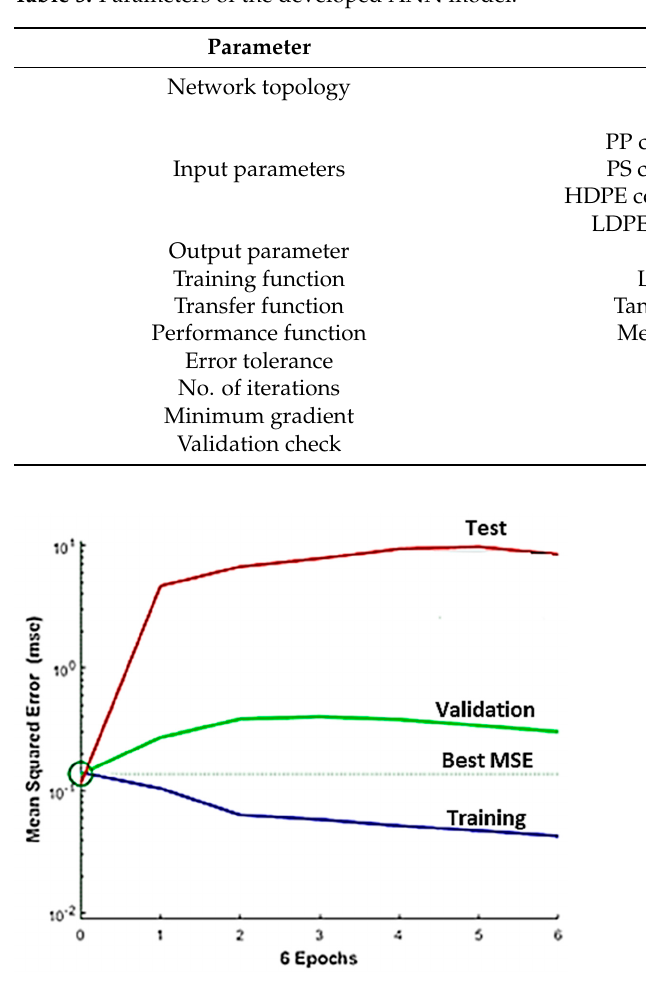
Figure 3. Optimum mean squared error.